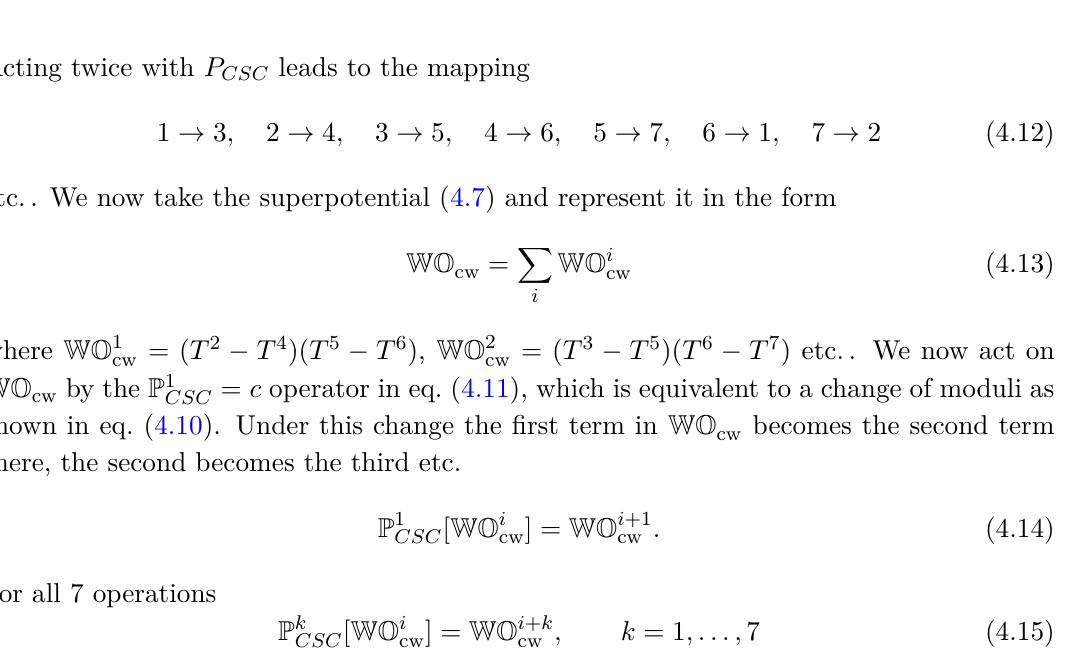
Figure 8 . This is a d operator in [61], such that d 3 = 1